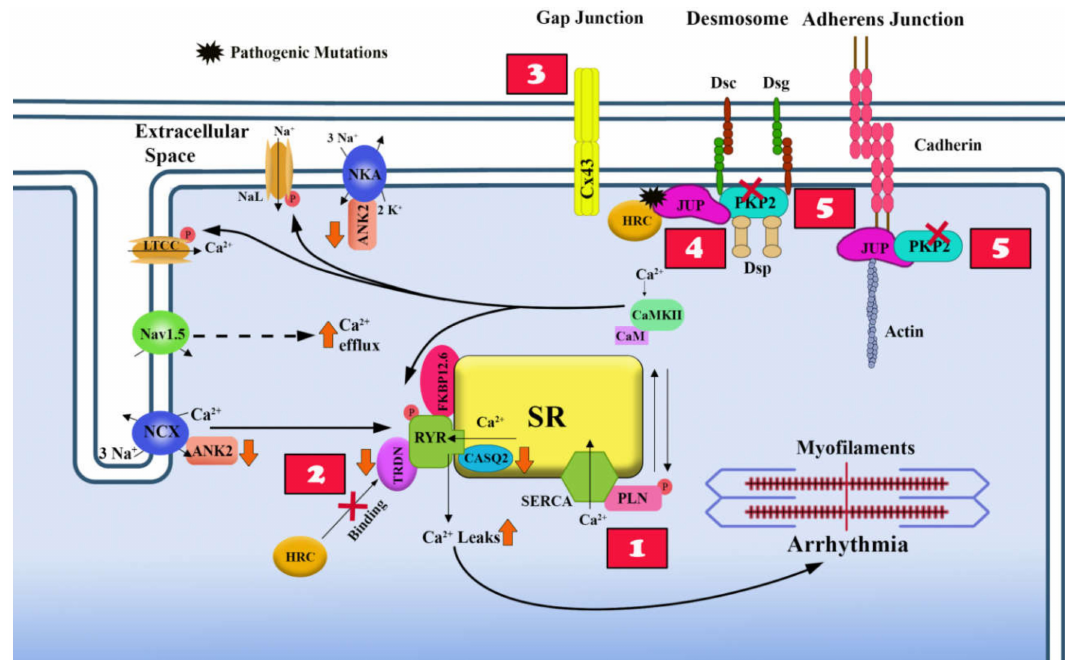
Figure 3. Proposed mechanisms causing arrhythmias in ACM. In healthy myocytes, the voltage-gated sodium channel (Nav1.5), the sensitive L-type calcium channels (LTCCs), the ryanodin receptors (RYR2), and SERCA are appropriately positioned to regulate the calcium induced calcium release cycle. Likewise, the connexin 43 (Cx43), plakoglobin (JUP), plakophilin 2 (PKP2) are positioned at desmosomes and adheren junctions to form a solid intracellular connection to the heart and to regulate membrane tra ffi cking of small molecules as well as electrical signals for coordinated contraction of the heart. In arrhythmogenic cardiomyopathy (ACM), normal calcium signaling in the heart seems to be perturbed. (1) Mutations in PLN prevent its ability to relieve SERCA, which repress the re-uptake of cytoplasmic Ca2 + back into the sarcoplasmic reticulum. (2) Mutations in RYR2 impair its interaction with FK506 binding protein 12.6 (FKBP12.6) in stabilizing the tetrameric structure of the channel and enhances Ca2 + leak into the cytoplasm. (3) Cx43-induced arrhythmias in the context of ACM are due to its mis-localization at the membrane secondary to structural defects caused by mutant desmosomal proteins. (4) Mutant JUP sequesters histidine-rich calcium-binding protein (HRC-BP) causing calcium leak into the cytoplasm. (5) PKP2 deficiency decreases levels of Ryr2, Ankyrin-B (Ank2), Triadin (TRDN) and Calsequetrin-2 (CASQ2), contributing to intracellular calcium homeostasis